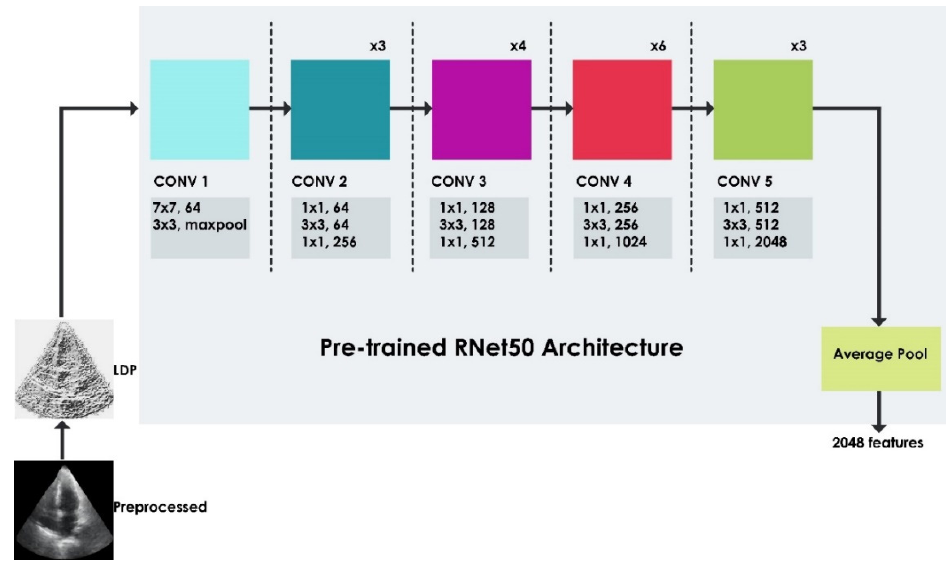
Figure 7. Feature generation blocks of the proposed method.